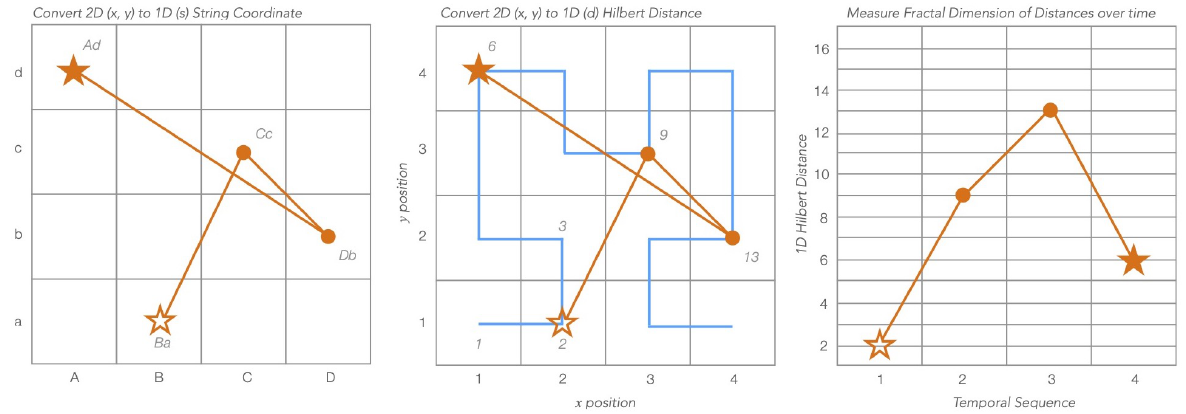
Figure 2. A scanpath demonstrates how a theoretical collection of four fixations could be represented over Cartesian, string, and Hilbert curve distances. All three figures represent four theoretical fixation points over a 4 by 4 unit space. The left figure illustrates how ScanMatch and MultiMatch reduce the 2D Cartesian coordinates to Ba, Cc, Db, and Ad. The middle figure illustrates a novel method for reducing the same Cartesian coordinates to Hilbert distances 2, 9, 13, and 6. A blue Hilbert curve overlay demonstrates the Hilbert curve distance’s path. The right figure shows the Hilbert curve distances to the left plotted against their temporal sequence. Start and end fixation are represented with (cid:73) and (cid:72) ,